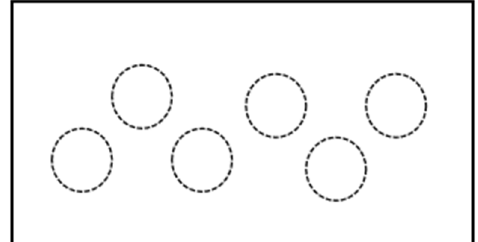
Figure 2. CIELAB color coordinate system [26].